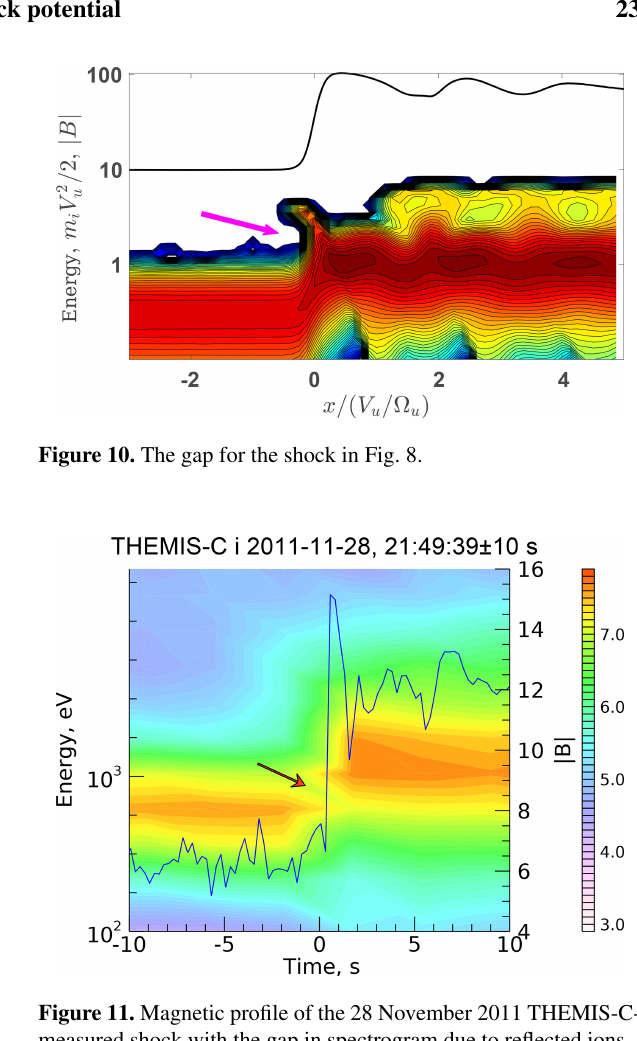
Figure 9. Magnetic profile of the 22 January 2012 THEMIS-B- measured shock.